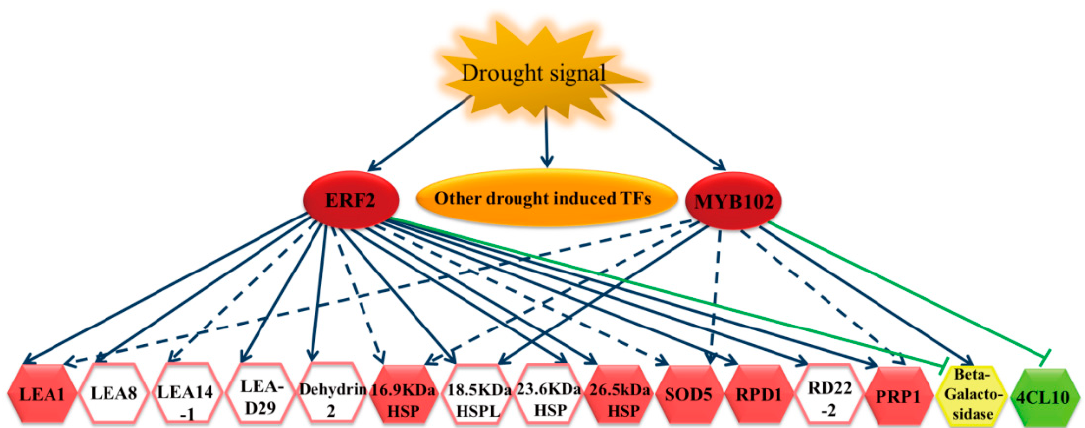
Figure 7. The regulatory network of BpERF2 and BpMYB102 in response to drought stress. Drought stress induces a series of transcription factors, including BpERF2 and BpMYB102, and the induced BpERF2 and BpMYB102 positively or negatively regulate a series of genes to improve drought tolerance. The solid blue lines indicate that BpERF2 or BpMYB102 directly regulates or induces the target gene expression; the solid green lines indicate that BpERF2 or BpMYB102 directly regulates or inhibits the target gene expression; the dotted lines indicate indirect regulation. The red hexagons highlight genes that were confirmed to confer drought tolerance to transgenic plants; the green hexagon indicates a gene that is related to drought sensitivity; the yellow hexagon indicates a gene that is not involved in drought tolerance; the hexagon without color shows genes that were not studied for their function in drought stress here.